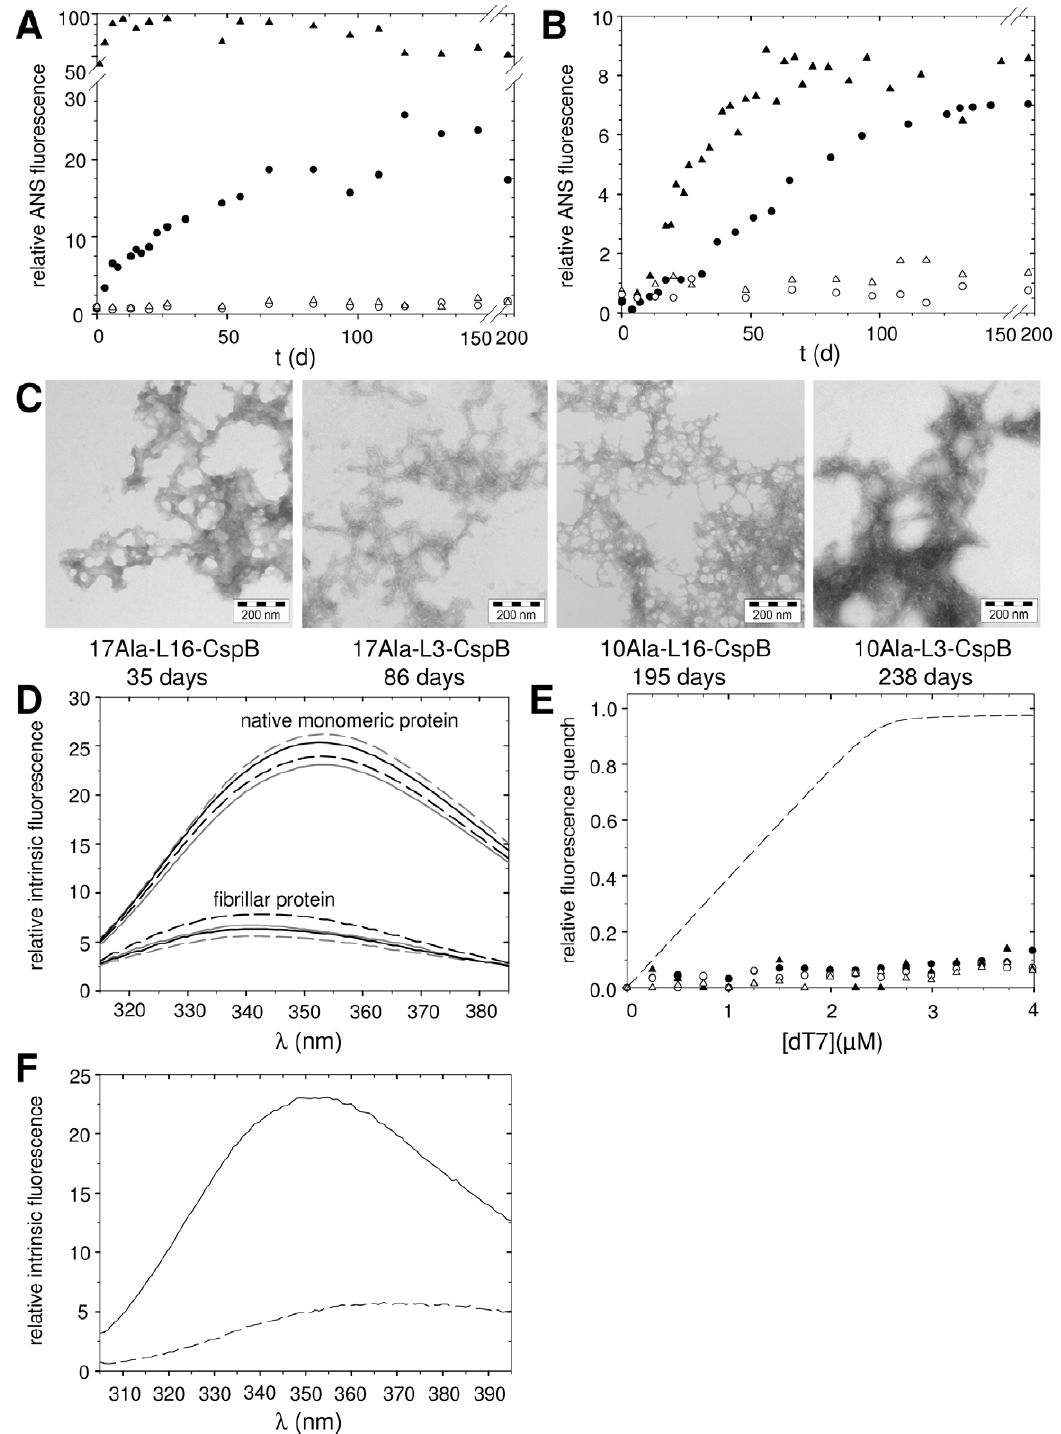
Figure 5. Characterization of the fibrils. The fusions were incubated at a protein concentration of 0.5 mM in 5 mM KH 2 PO 4 , 100 mM NaCl, pH 7.5 at 37 u C. A ANS fluorescence of the fusion proteins. 17Ala-L16-CspB, filled triangles; 17Ala-L3-CspB, filled circles; 17Ala-L16-MCspB, open triangles; 17Ala-L3- MCspB,opencircles. B ANSfluorescenceofthefusionproteins. 10Ala-L16-CspB, filledtriangles; 10Ala-L3-CspB, filledcircles;10Ala-L16-MCspB, opentriangles; 10Ala-L3-MCspB, open circles. C Electron micrographs of the fusions after incubation times of 35, 86, 195 and 238 days. D Fluorescence spectra of the native monomeric fusions and the variants in the fibrillar state. L3-variants are shown in gray; L16-variants in black; variants with 10 alanines are shown as solid line; variantswith17alaninesasdashedline. E BindingofdT7toCspBinthefibrils.Variantswith10alaninesareshownwithfilledsymbols;variantswith17alanines with open symbols; variants with a linker of 3 amino acids are shown as circles; variants with a linker of 16 amino acids as triangles. The dashed line correspondstothebindingofdT7tomonomeric10Ala-L3-CspB.Thenegativecontrols,variantswithoutalanines( D Ala-L3/L16-CspB),didnotformfibrilsover the observed time period. F Fluorescence spectra of the protease-digested and solubilized fibrils. 17Ala-L3-CspB, solid line; 17Ala-L16-CspB, dashed line.